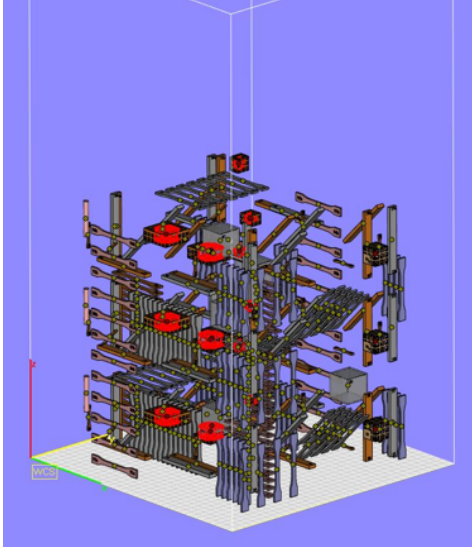
Figure 1. Build layout in Magics